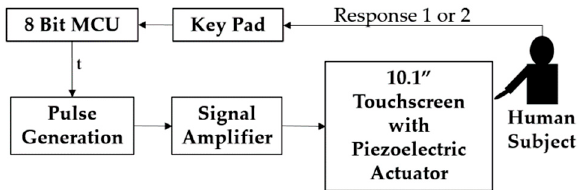
Figure 4. Experimental setup of a perception study measuring temporal discrimination thresholds on a 10.1 inch touchscreen. The participant passively felt tactile feedback on the touchscreen and then